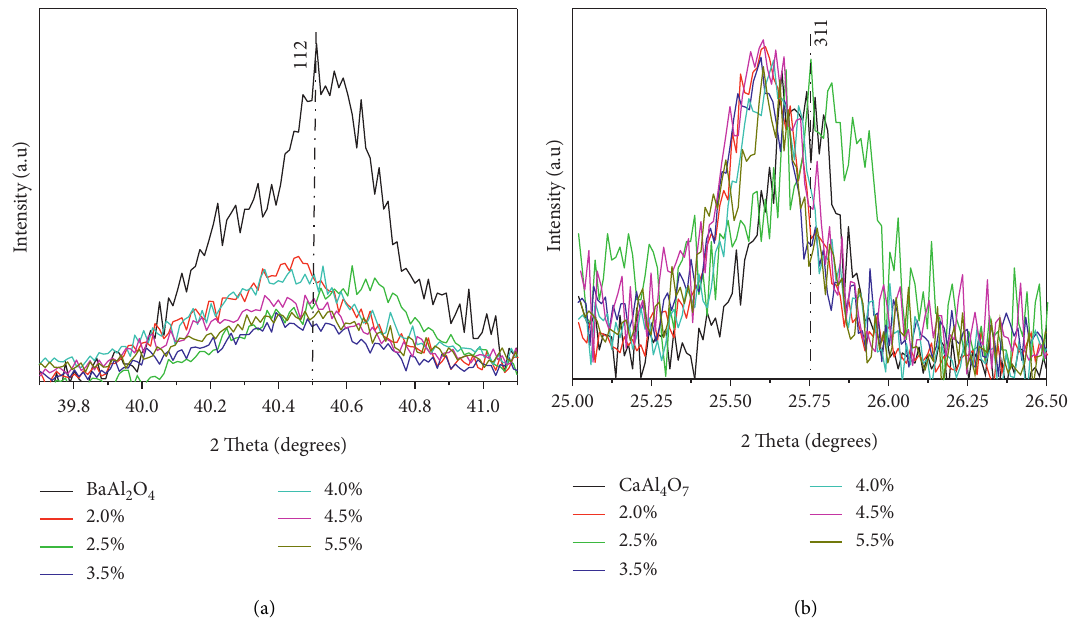
Figure 3: Examination of the peaks for BC and BC: x % Eu 3+ (0 ≤ x ≤ 5.5) in the (a) (112) direction and (b) (311)